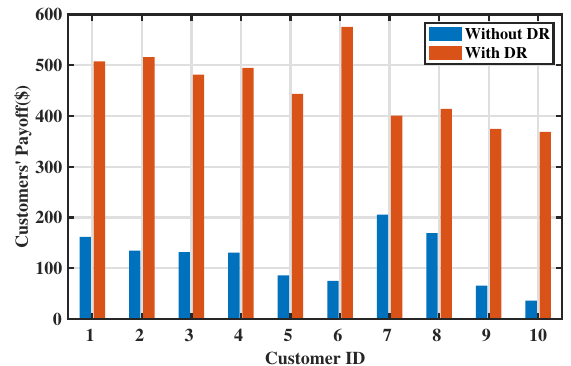
Figure 7. Customers’ daily payoff with and without DR.